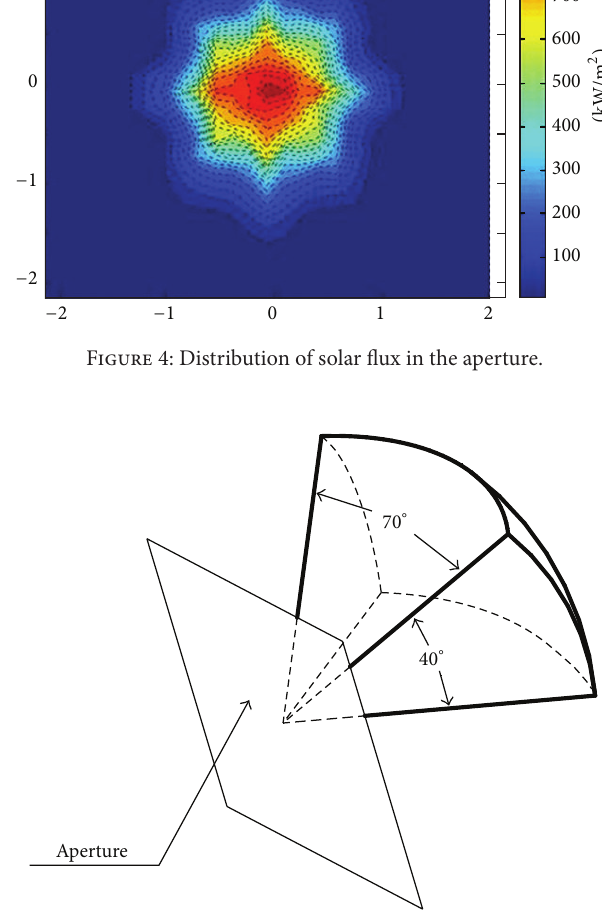
Figure 5: Range of solar irradiation